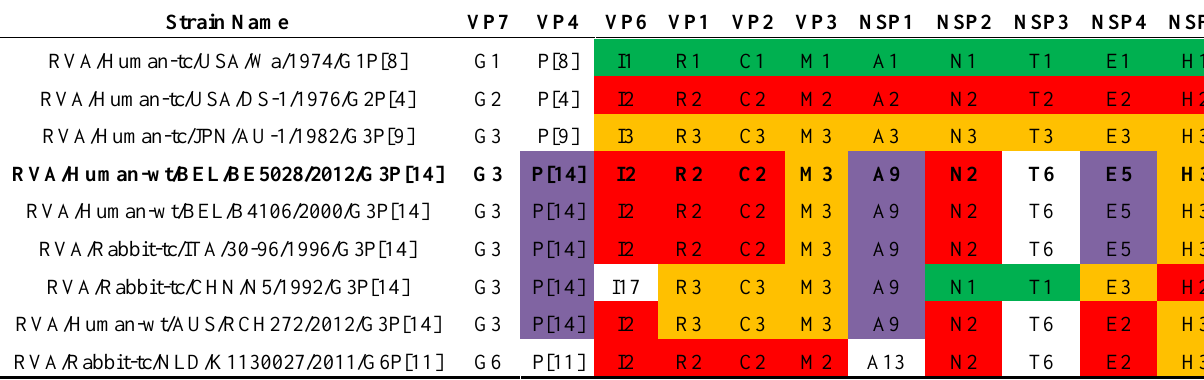
Table 1. Genotype constellations of completely sequenced lapine(-like) and reference RVA strains. Green, red, and orange indicate Wa-like, DS-1-like, and AU-1-like gene segments, respectively. Violet indicates typical lapine